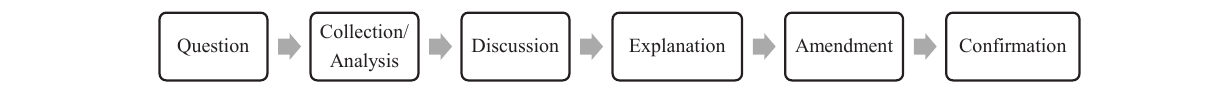
FIGURE 1 | The QC/ADEAC inquiry model.